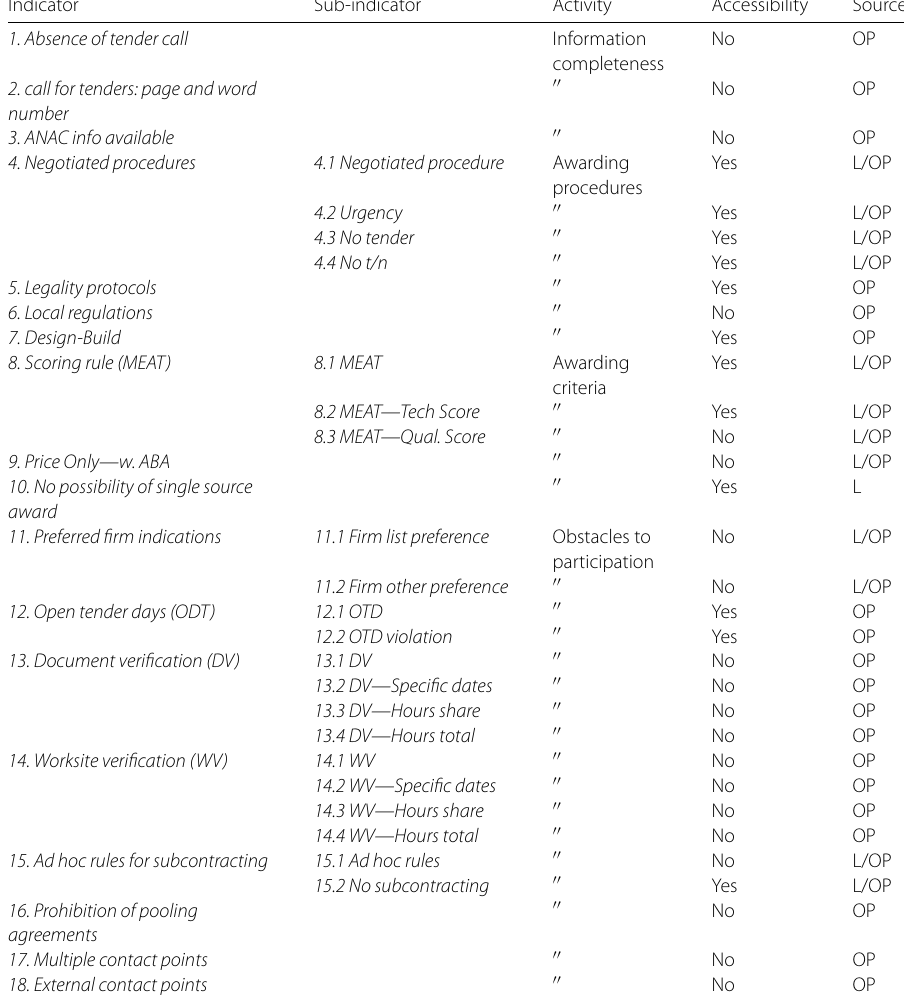
Table 1 Corruption indicators: the eighteen red flags Indicator Sub-indicator Activity Accessibility